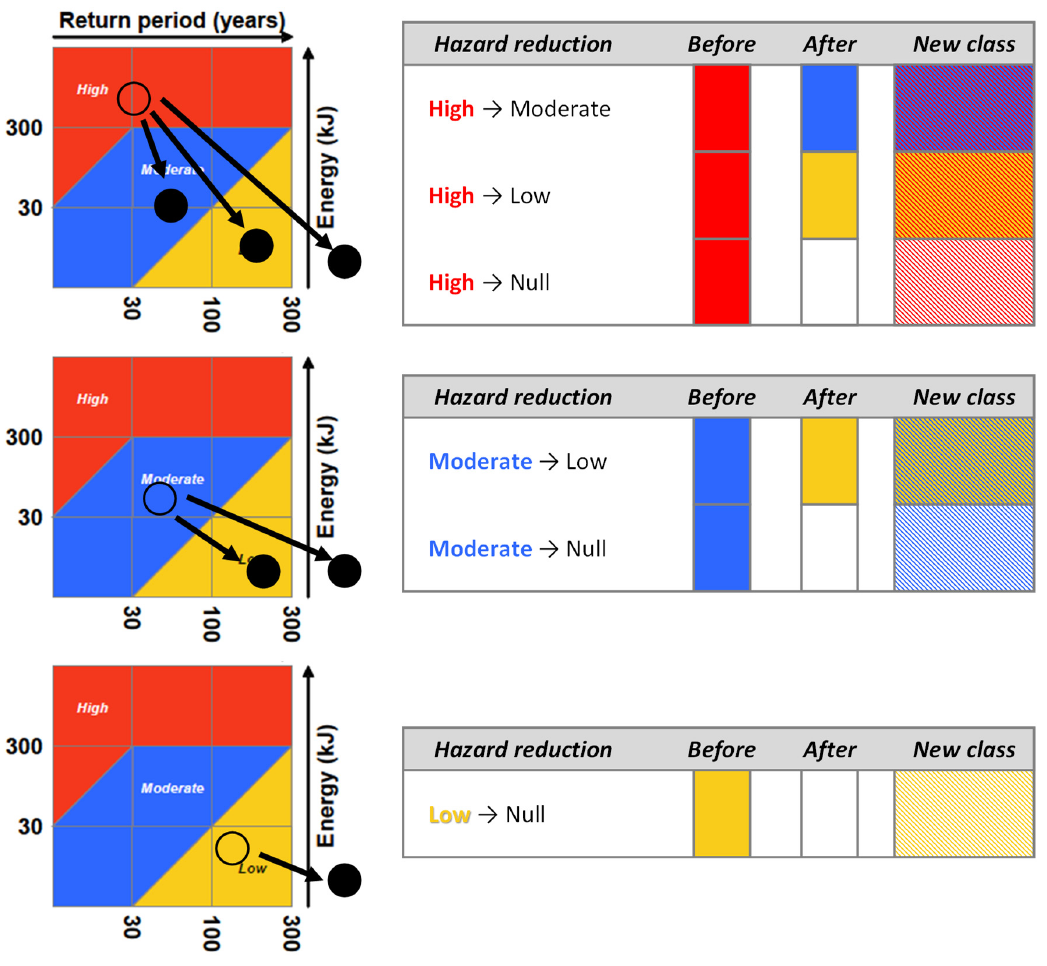
Figure 2. Requalification of hazard zones and corresponding representation in hazard zoning maps, with reference to the rock fall intensity–frequency diagram used in the Swiss Codes.